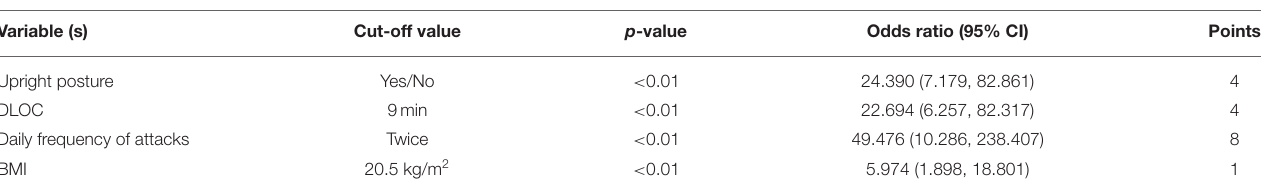
TABLE 4 | Coefficients of binary logistic regression in training